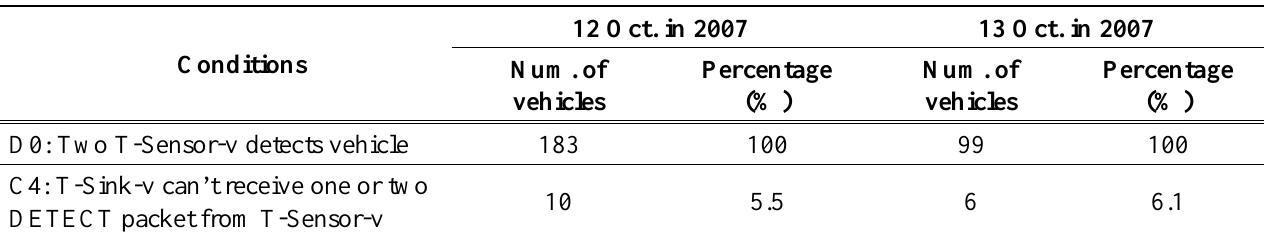
Table 3. Old highway testbed. 100% of vehicles were detected by two T-Sensor-v node and 94% of them were relayed to the T-BS-com-v node.